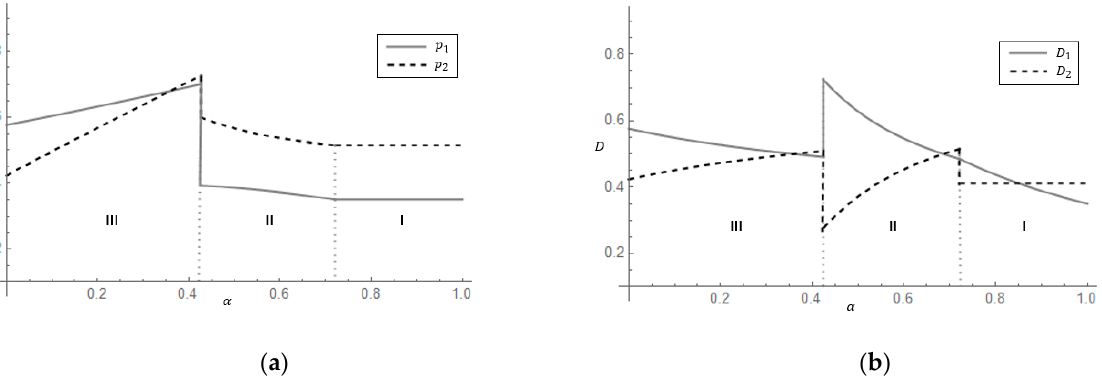
Figure 2. The influence of α on product price and demand. ( a ) The influence of α on product price. ( b ) The influence of α on product demand.